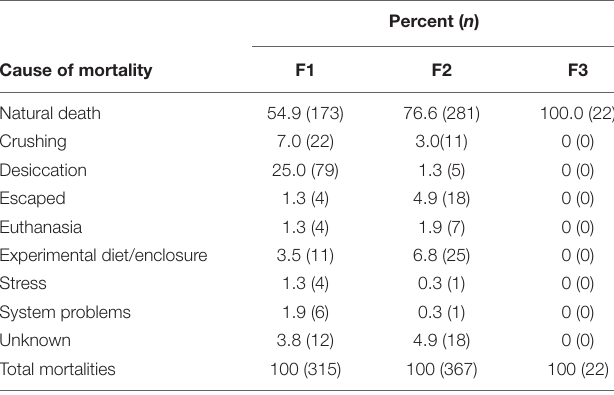
TABLE 3 | Octopus chierchiae mortalities by generation classified by cause of